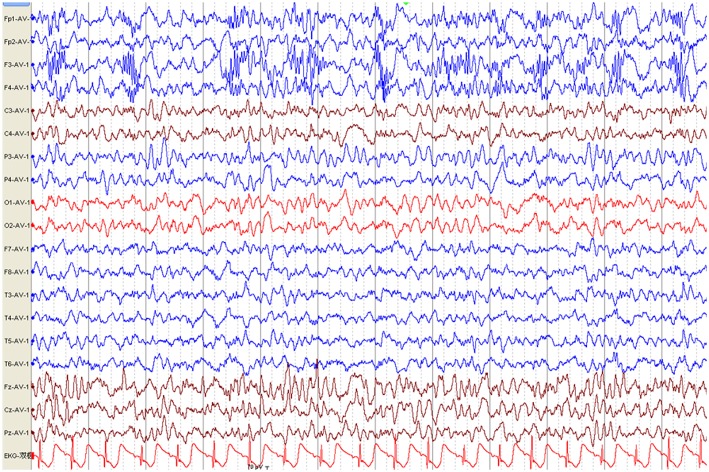
Electroencephalography pattern of a 4-year and 5-month-old female child with anti-N-methyl-D-aspartate receptor encephalitis (Case 8), who presented with clonic seizures of her right limbs as her initial symptom. EEG was recorded 43 days after symptom onset and before immunotherapy. EEG shows bilateral frontal-predominant fast activity at 20–30 Hz riding on the generalized rhythmic delta activity (EDB).